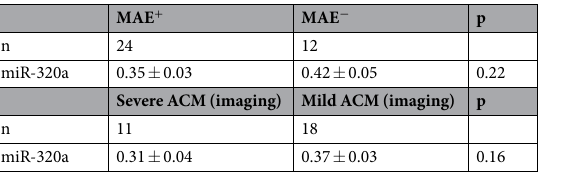
Table 4. miR-320a expression does not vary in subgroups defined by categorical variables associated with Arrhythmogenic CardioMyopathy (ACM) severity. MAE + , patients presenting with a history of Major Arrhythmic Events; MAE − , patients not presenting history of MAE; miR-320a, relative expression levels showed as mean fold change ± SEM (calculated with respect to HC). Severe/Mild ACM (imaging), patients presenting severe or mild ventricular impairment, respectively (defined as absence of ventricular dilation and/or bulging at cardiac echocardiography or magnetic resonance imaging). For each variable the p-value of the Fisher’s exact test is